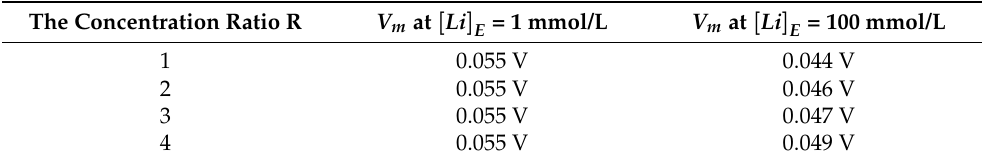
A numerical description of the membrane potential values with respect to the extra- cellular lithium concentration can be obtained based on the classical transport of lithium ions Li-6 as in graph (b) of Figure 9. See Table 24. Table 24. The table shows the membrane potential values at extracellular lithium concentration of 1 mmol/L and 100 mmol/L, at different concentration ratios R and based on the classical transport of Li-6 as in graph (b) of Figure 9.